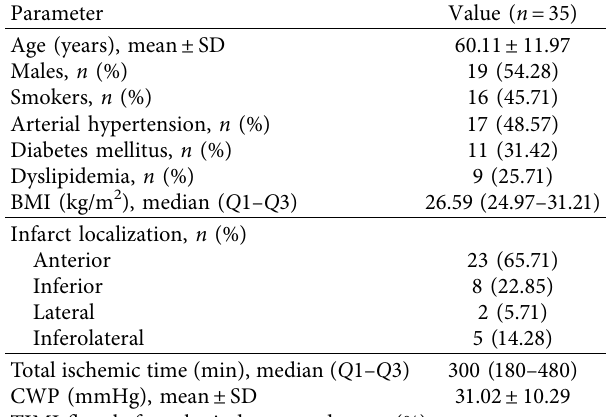
Table 1: Clinical and angiographic patient characteristics.